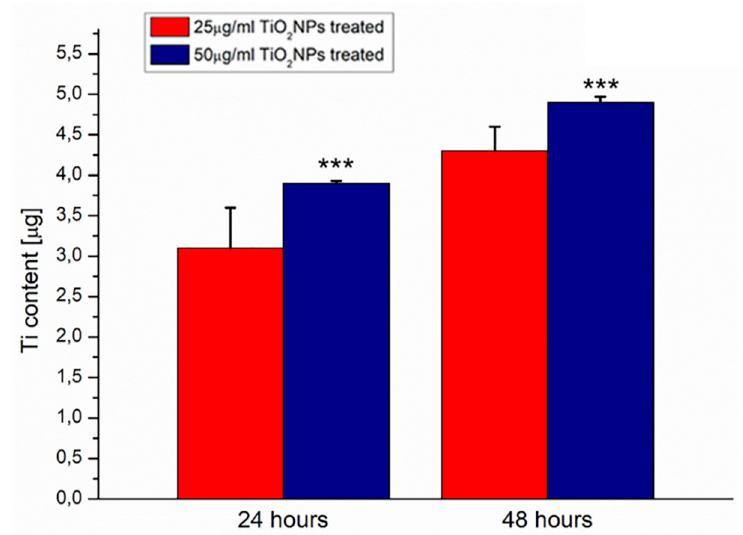
Figure 2. Uptake of TiO2NPs in human breast adenocarcinoma (MCF-7) cell line after 24 and 48 h of TiO 2 NP exposure at two concentrations (25 and 50 µ g / mL). Data reported were calculated as average ± SD on three independent experiments, and the statistical significance respect to the control was represented (*** p -value < 0.005).